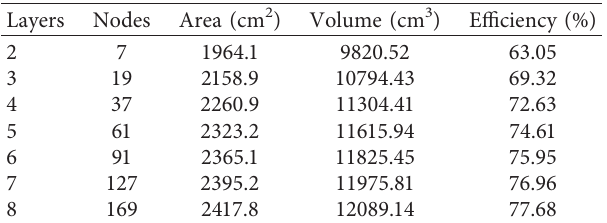
Figure 4: Construction of ultrasonic vibration network tool head for honeycomb structure. Table 1: Efficiency of ultrasonic vibration network honeycomb structure with different